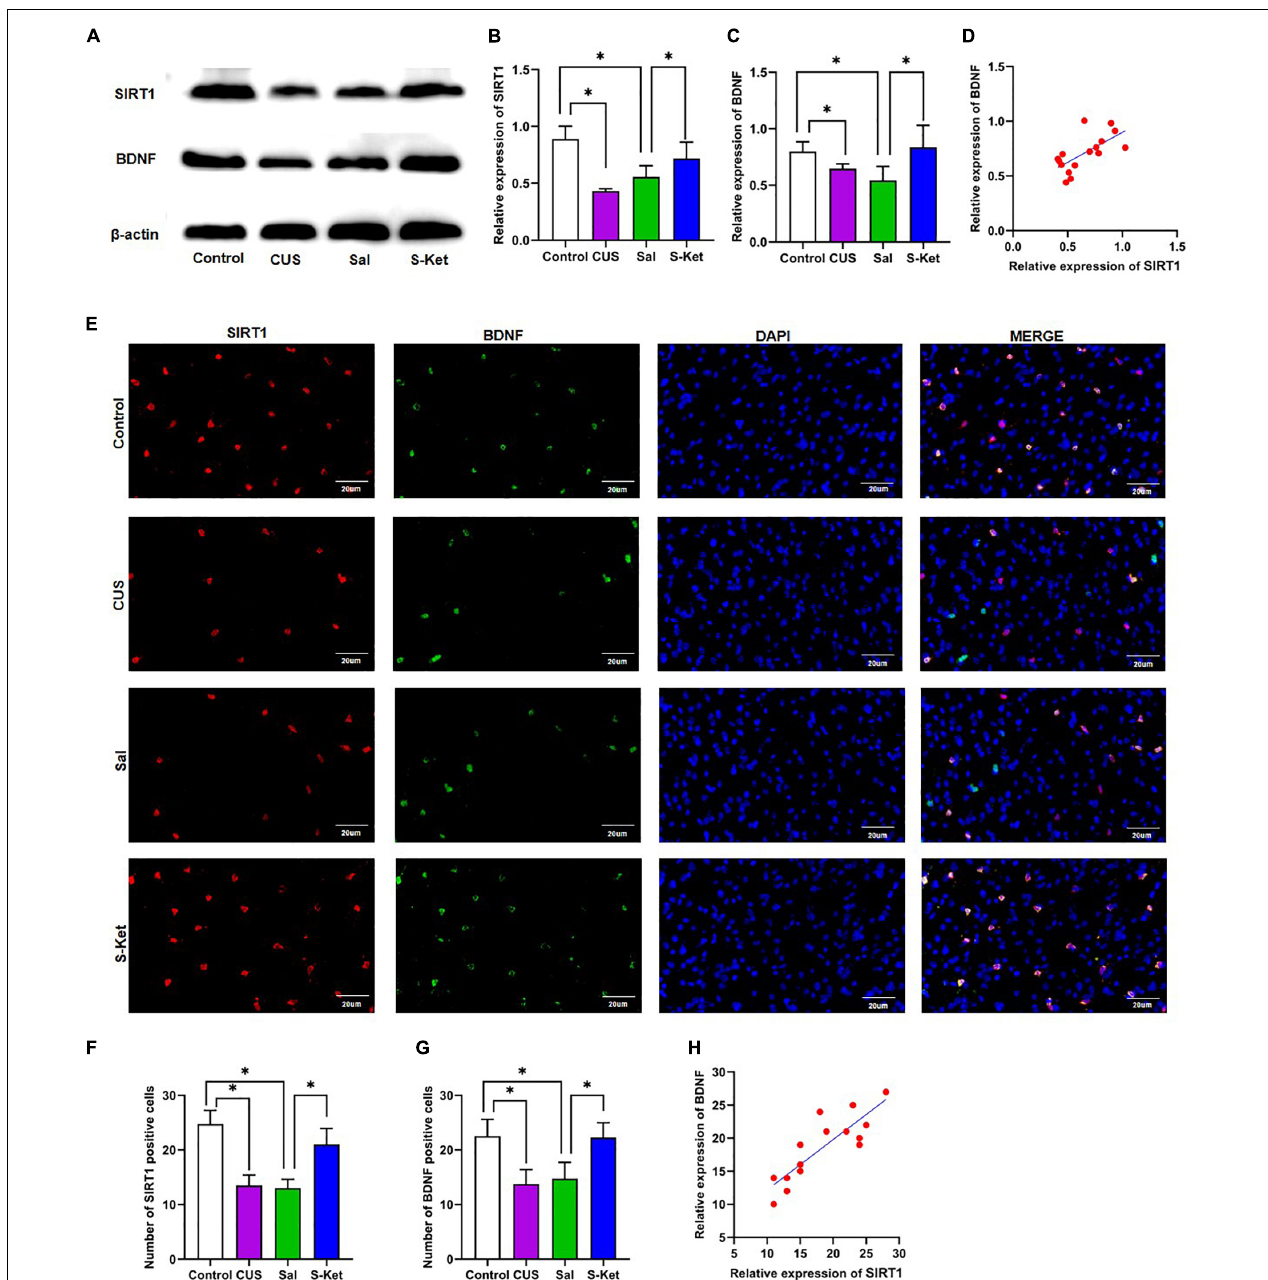
FIGURE 4 | S-ketamine upregulated the SIRT1 and BDNF expression in mPFC. (A) Bands of SIRT1 and BDNF obtained from the Western blot test. (B) Relative expression of SIRT1 protein ( n = 3). (C) Relative expression of SIRT1 protein ( n = 3). (D) Correlation between SIRT1 protein and BDNF protein. (E) Images of SIRT1- and BDNF-positive cells obtained from the immunofluorescence test. (F) Number of SIRT1-positive cells ( n = 3). (G) Number of BDNF-positive cells ( n = 3). (H) Correlation between SIRT1-positive and BDNF-positive cells. The photomicrographs are typical images of SIRT1- and BDNF-positive cells (400 × ). The data are expressed as the mean ± standard error, and ∗ P <